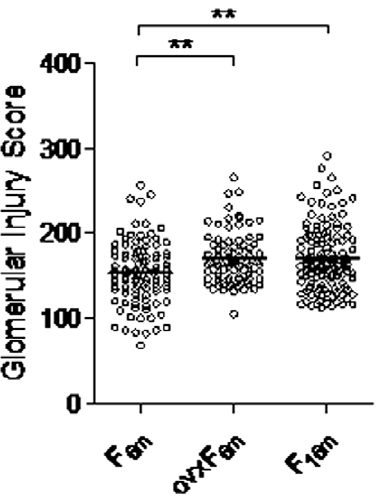
Figure 1. Distribution of GIS in premenopausal, ovariecto- mized and postmenopausal F2 (Dahl S x R)-intercross cohorts. Distribution of GIS in premenopausal F2 (F 6m , n=102) female hybrids at 6 months of age (8% NaCl challenge begun at 3 months of age); ovariectomized female F2 (ovxF 6m , n=116) hybrids at 6 months of age (8% NaCl challenge begun at 3 months of age) and postmenopausal F2 (F 16m , n=130) female hybrids at 16 months of age (8% NaCl challenge begun at 14 months of age). Means are shown as horizontal lines. ** P , 0.01 (one-way ANOVA followed by Holm-Sidak test for multiple comparisons).